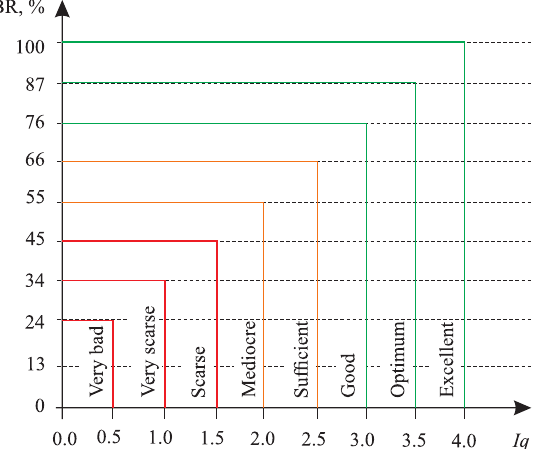
Fig. 2. Overall assessment of CBR index for road mixtures with “low bearing capacity”